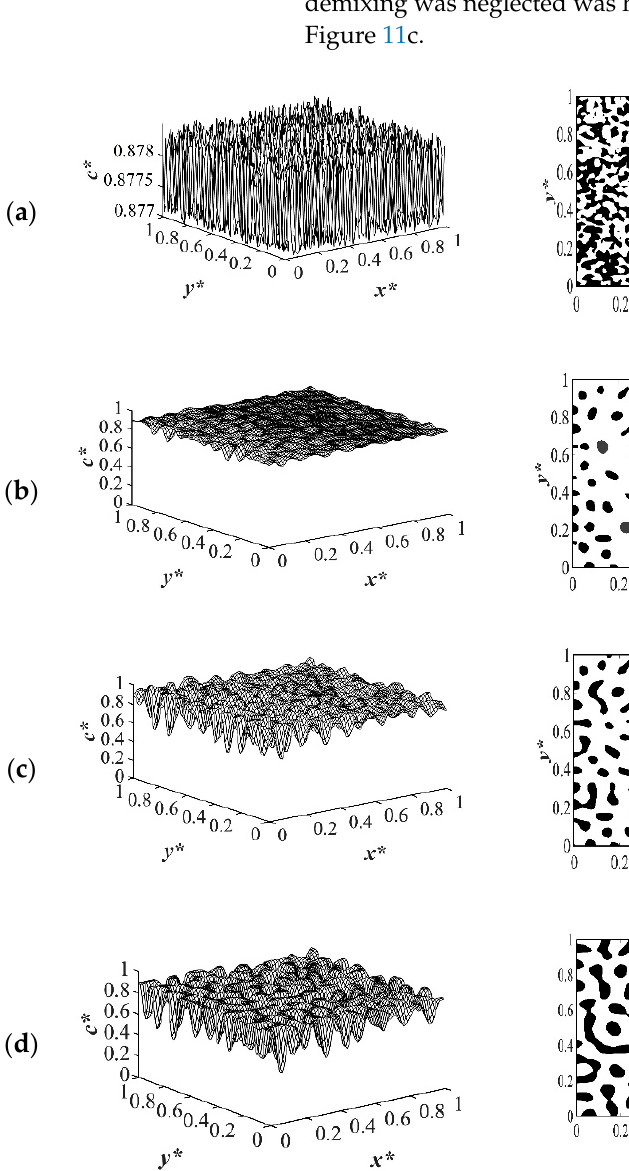
Figure 10. Spatial concentration ( left column), phase separated pattern ( middle column) and temper- ature ( right column) profiles for off-critical quench without considering enthalpy of demixing c *